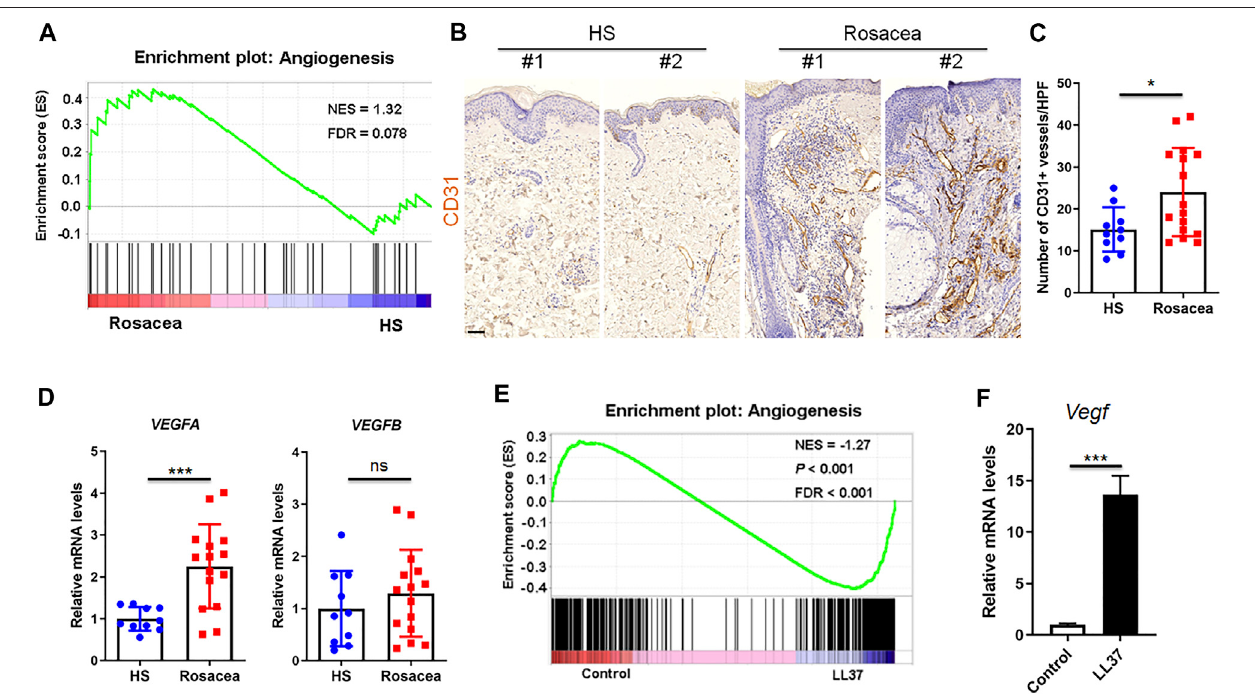
FIGURE1| Angiogenesisisupregulatedinrosaceaskinsamples. (A) GSEAplotsofangiogenesisfromRNA-Seqdatainrosacealesionsandhealthyskin(HS).The plots are displayed with normalized enrichment score (NES) and false discovery rate (FDR). (B,C) Immunohistochemical staining of CD31 and quantitative analysis of CD31-positivevesselsonskinsectionsfromhealthyskinandrosacealesions.Scalebar:50 μ 0. (D) mRNAexpression of VEGFA and VEGFB inskintissuesfromhealthy skinandrosacealesionsdetectedbyRT – qPCR. (E) GSEAplotsofangiogenesisfromRNA-SeqdatainskintissuesfromLL37-inducedrosaceamousemodeland controlmouse. (F) Vegf mRNAexpressioninskinsamplesfromLL37-inducedrosacea-likemousemodelandcontrolmousebyRT-qPCR.Datarepresent mean ± SEM from three independent experiments. Statistical signi fi cance was determined by two-tailed unpaired Student ’ s t -test (C,D,F) . NS, not signi fi cant. * p < 0.05 and *** p <